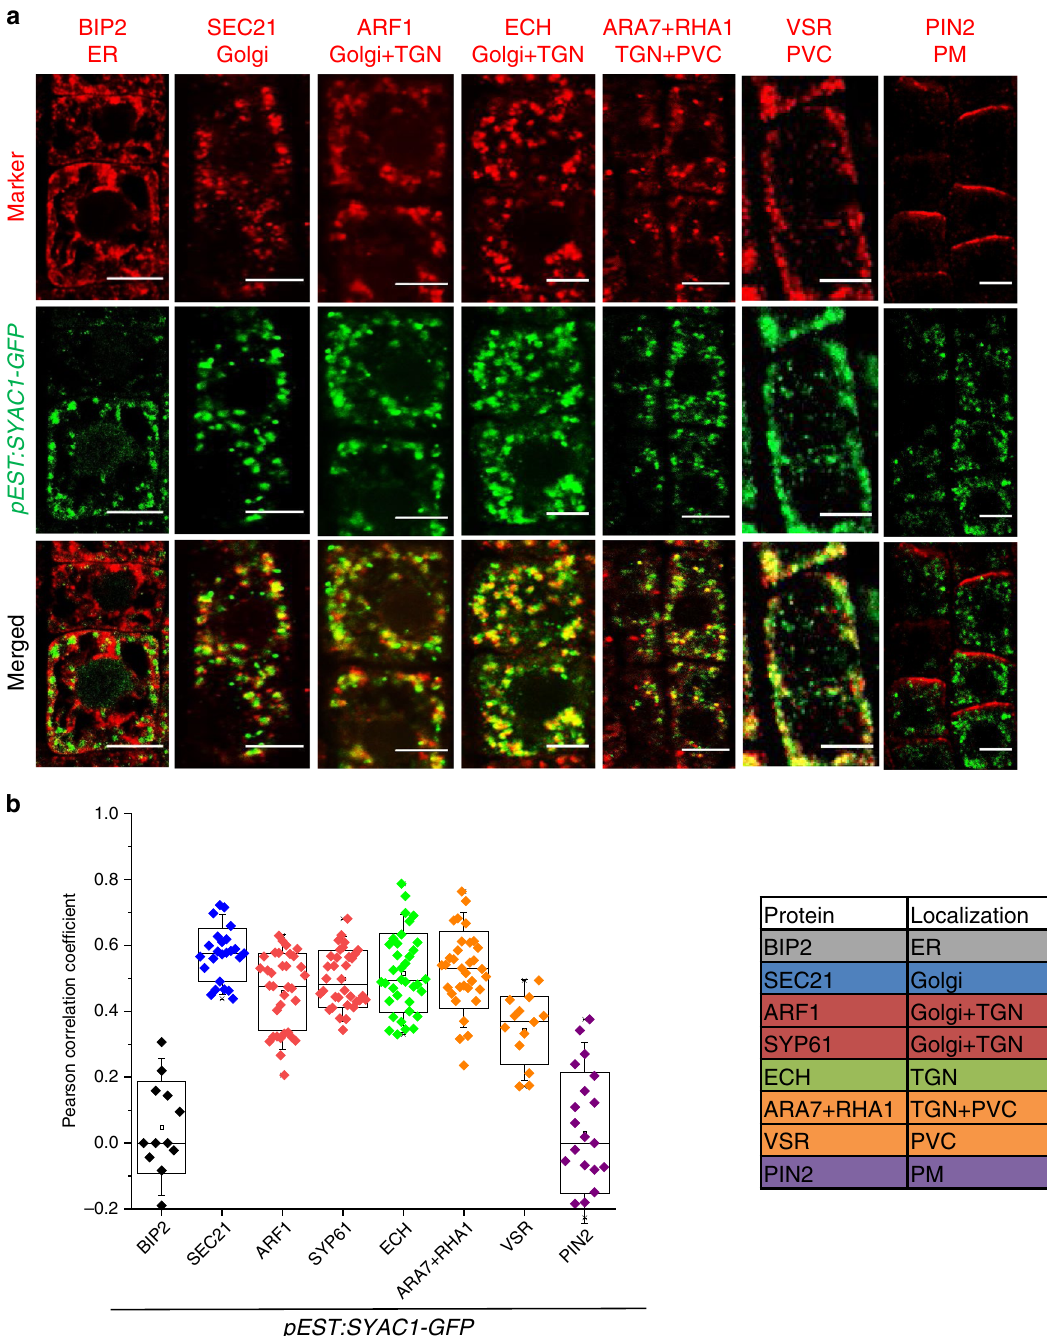
Fig. 3 SYAC1 colocalizes with Golgi/TGN/endosomal/PVC markers. Co-imunolocalization of SYAC1-GFP with markers for different subcellular compartments ( a ) and quanti fi cation of colocalization using Pearson correlation coef fi cient ( b ). Five-day-old pEST:SYAC1-GFP seedlings grown on mock medium treated with 5 µ M estradiol for 6 h used in co-imunolocalization experiments ( n = 10 roots with 1 – 5 epidermal cells each). Co-imunolocalization performed using antibodies against anti-GFP and subcellular markers. In the boxplots, center lines show the medians; box limits indicate the 25th and 75th percentiles as determined by Origin software; whiskers extend 1.5 times the interquartile range from the 25th and 75th percentiles, individual data points are represented by dots. ER Endoplasmic reticulum, TGN trans -Golgi network, PVC prevacuolar compartment, PM plasma membrane. Scale bar 5 µ